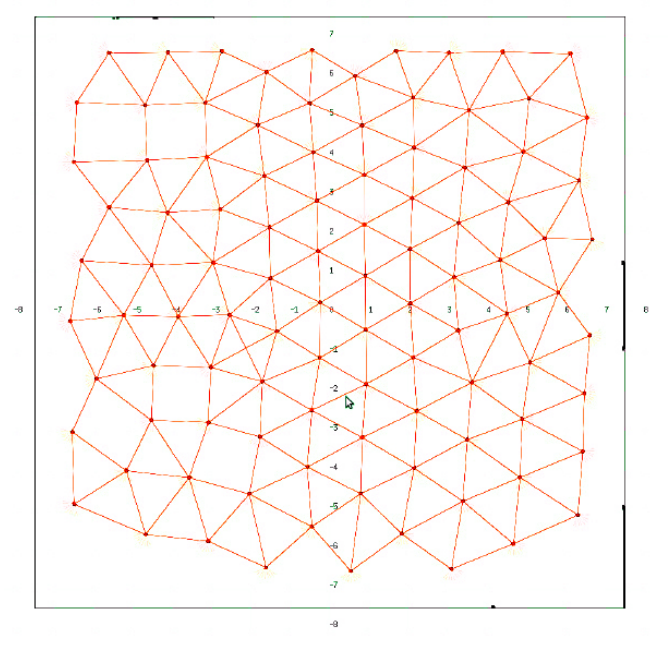
Figure 7. SPF deployment for 100 robots in an environment without obstacles.